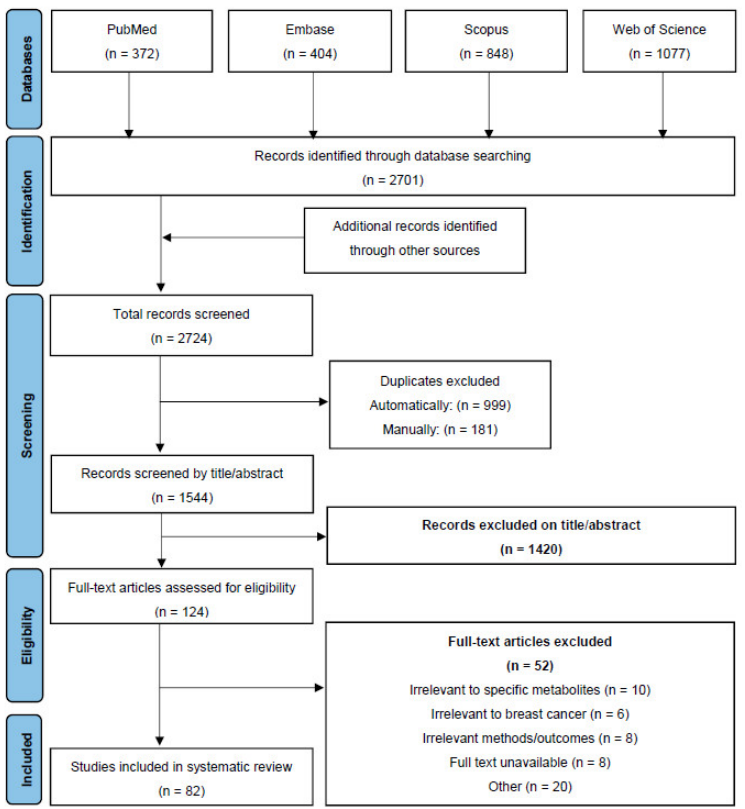
Figure 3. PRISMA Flow Diagram depicting the screening process for the review.